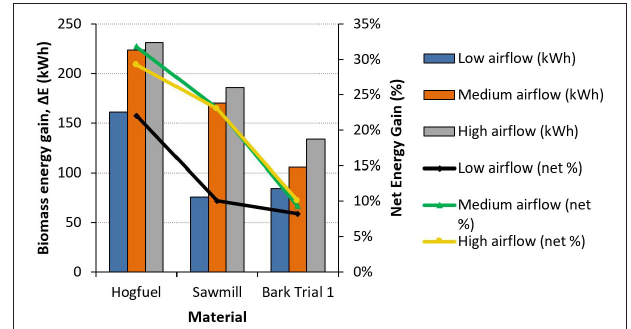
FIGURE 5 | Energy gains ( 1 E) (kWh) from natural air drying of biomass without supplemental heat, along with net energy gain (%) (including equipment energy consumption) for hog fuel, woodchips, and bark trials.